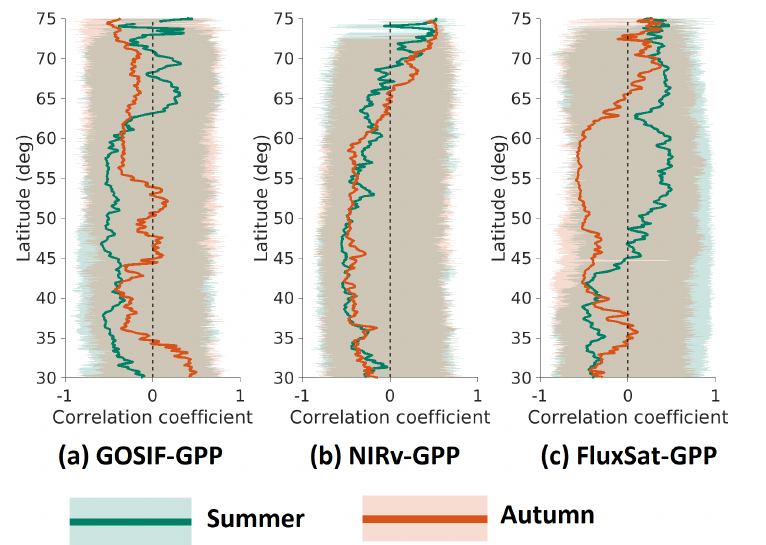
Figure 3. Latitudinal distribution of Pearson’s correlations ( p < 0.05) between T spring anomaly to summer (green) and autumn (orange) GPP anomaly, for: ( a ) GOSIF-GPP, ( b ) NIRv-GPP, and ( c ) FluxSat-GPP. The shaded area represents one standard deviation for the pixels with each latitude intervals (0.05 ◦ ). The solid line represents the mean values for the pixels with each latitude intervals. All the values have been processed using the moving average of every five consecutive